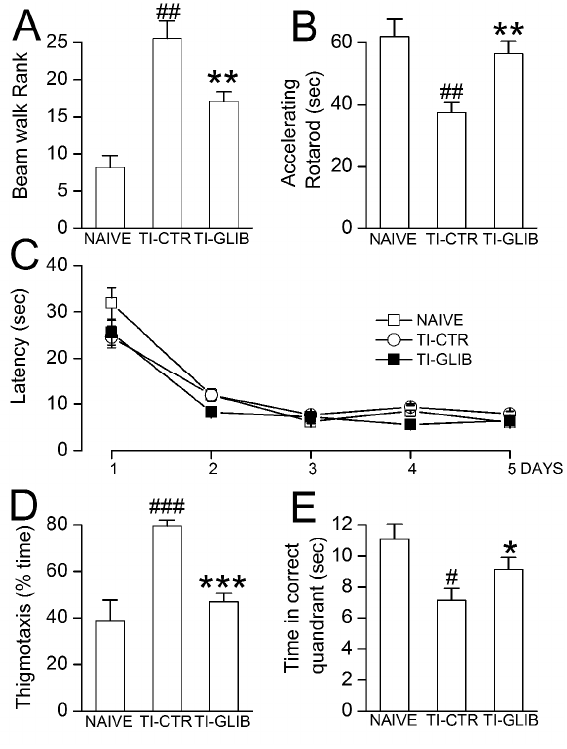
Figure 7. Prenatal low dose glibenclamide infusion improves vestibulomotor and cognitive function following tandem insults (TI). ( A – E ) performance at P35 on the beam walk test ( A ), at P35 on the accelerating Rotarod ( B ), at P37–41 on incremental spatial learning ( C ), at P35 on thigmotaxis ( D ), and at P49 on rapid spatial learning ( E ), in pups subjected to no injury (naïve), or in pups subjected to TI whose mother was administered vehicle (TI-CTR), or in pups subjected to TI whose mother was administered low dose glibenclamide infusion after IUI (TI-GLIB); data from 21 naïve, 28 TI-CTR and 28 TI-GLIB pups, respectively; ## and ### , p < 0.01 and p < 0.001, respectively, comparing naïve and TI-CTR; *, ** and ***, p < 0.05, p < 0.01 and p < 0.001, respectively, comparing TI-CTR and